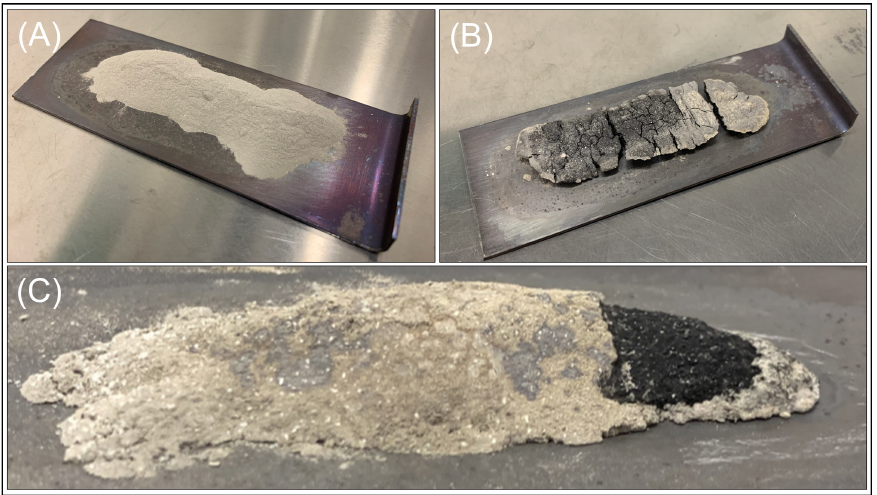
Figure 4. Images of the powder bed pre- and post-nitriding. ( A ) Pure Al powder pre-nitriding, ( B ) Al powder nitrided at 530 °C for 6 h resulting in fully agglomerated Al:AlN and ( C ) Al powder nitrided for 6 h at 510 °C resulting in partially agglomerated Al/AlN, which was sufficiently friable to manually process into a